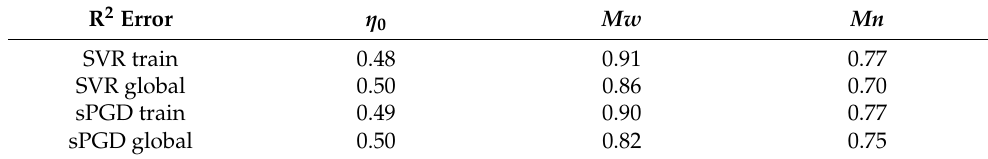
Figure 12. Results of zero-shear viscosity and weight and number average molecular weights predicted by SVR and sPGD methods versus the experimental ones. The blue dots correspond to training data, and the red stars correspond to test data for HDPE and UHMWPE indiscriminately. Table 5. R 2 scores errors for the determination of η 0 , Mw and Mn with SVR and sPGD methods. R 2